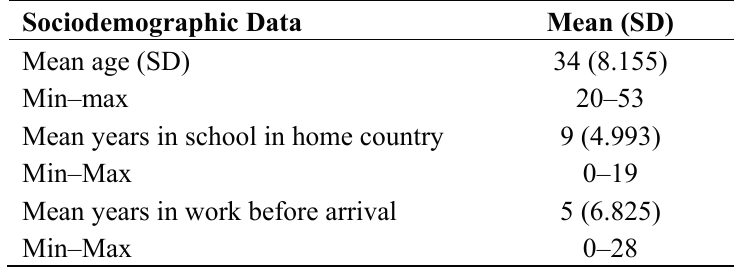
Table 3. Sociodemographic data; mean age, years in school, in work and number of children among female participants in three measures in the Lifestyle course in Södertälje ( n =